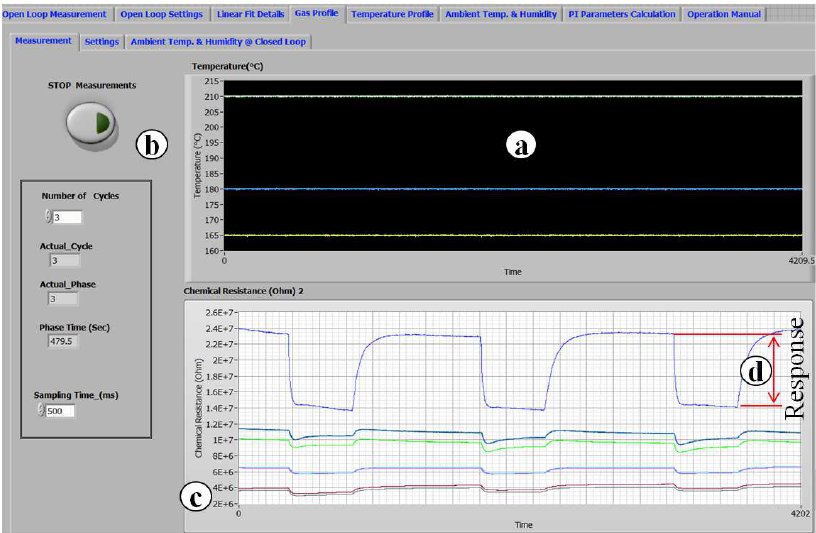
Figure 6. Response and temperature versus time: ( a ) working temperature versus time; ( b ) VI front panel; ( c ) chemical resistance vs. time; ( d ) amplitude of the